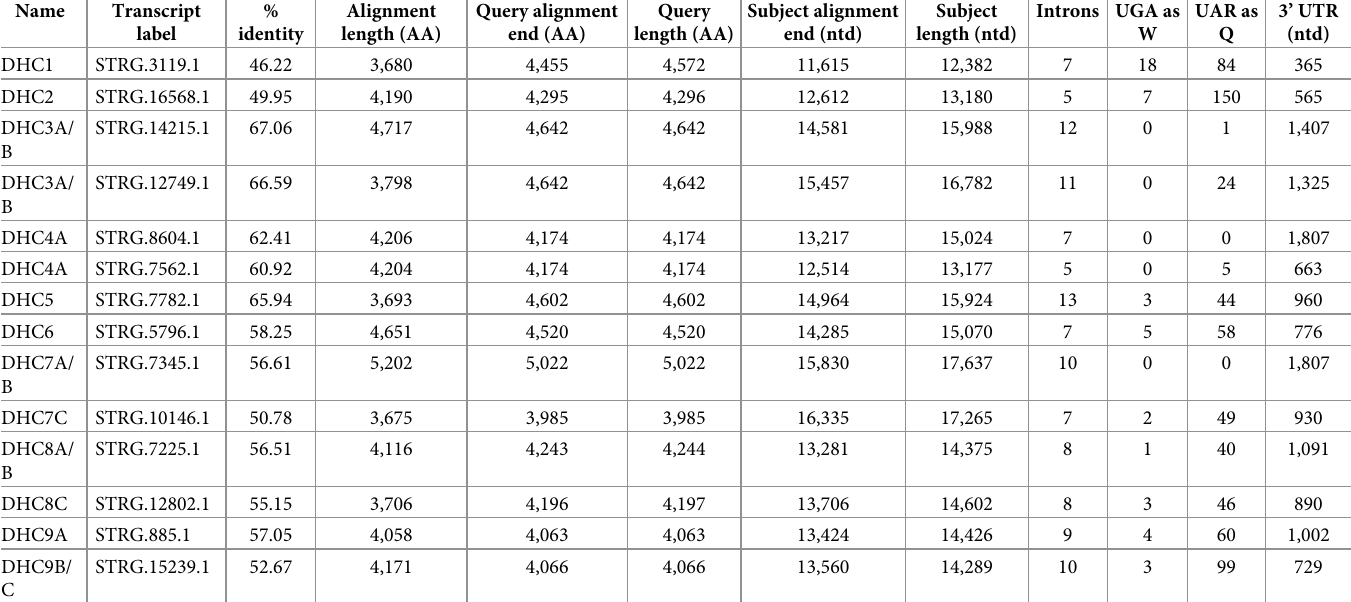
Table 2. Comparison of Dynein Heavy Chain (DHC) sequences from Symbiodinium kawagutii as queries to Amoebophrya sp. ex Karlodinium veneficum StringTie transcripts.